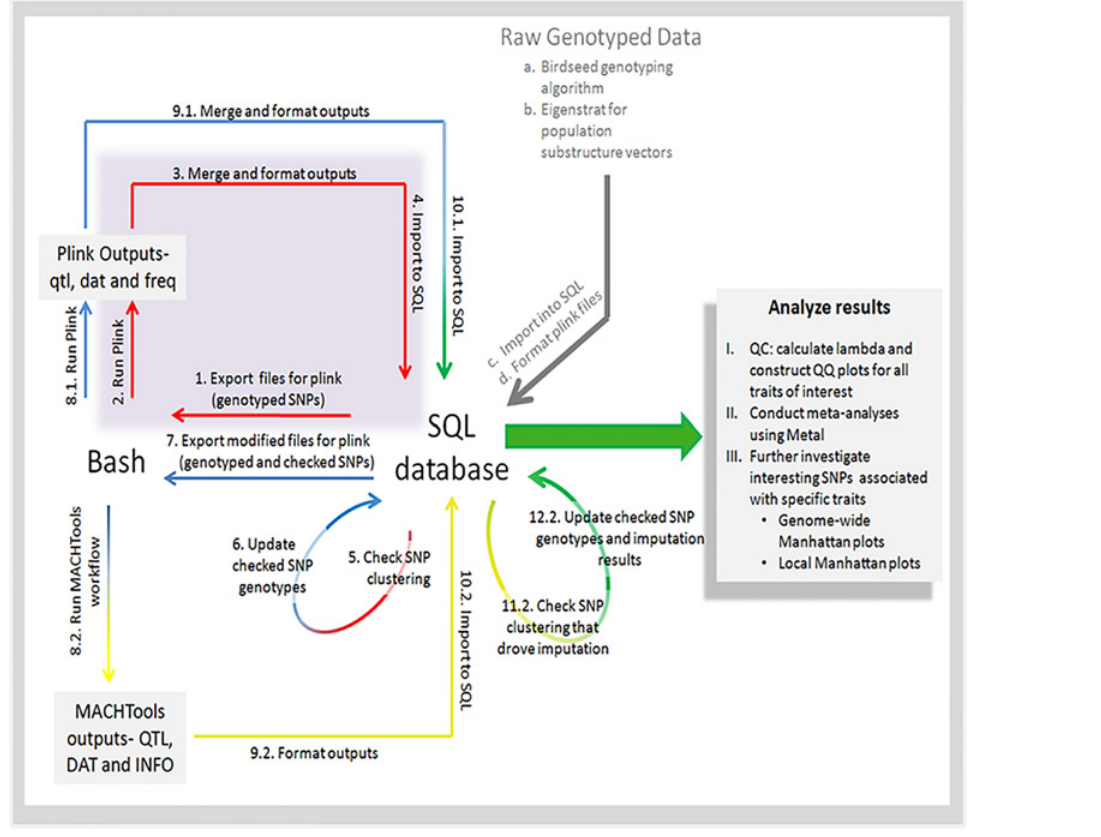
Fig 1. Data analysis workflow